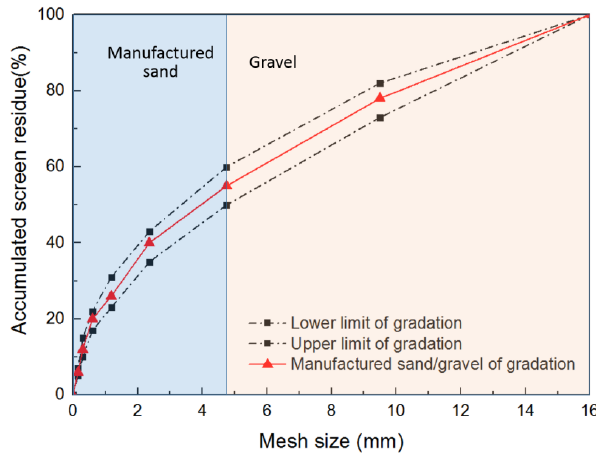
Figure 2. Manufactured sand and gravel gradation.